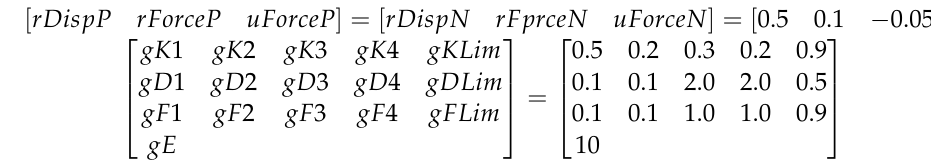
Figure 6. The skeleton curve model of infill.